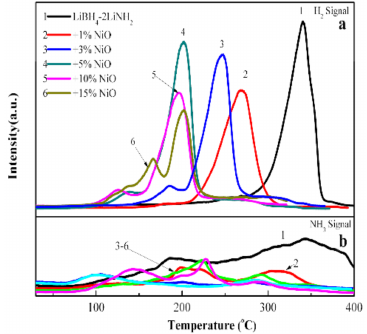
Figure 7. MS-H 2 signals ( a ) and NH 3 signals ( b ) of the as-milled LiBH 4 -2LiNH 2 - x wt. %